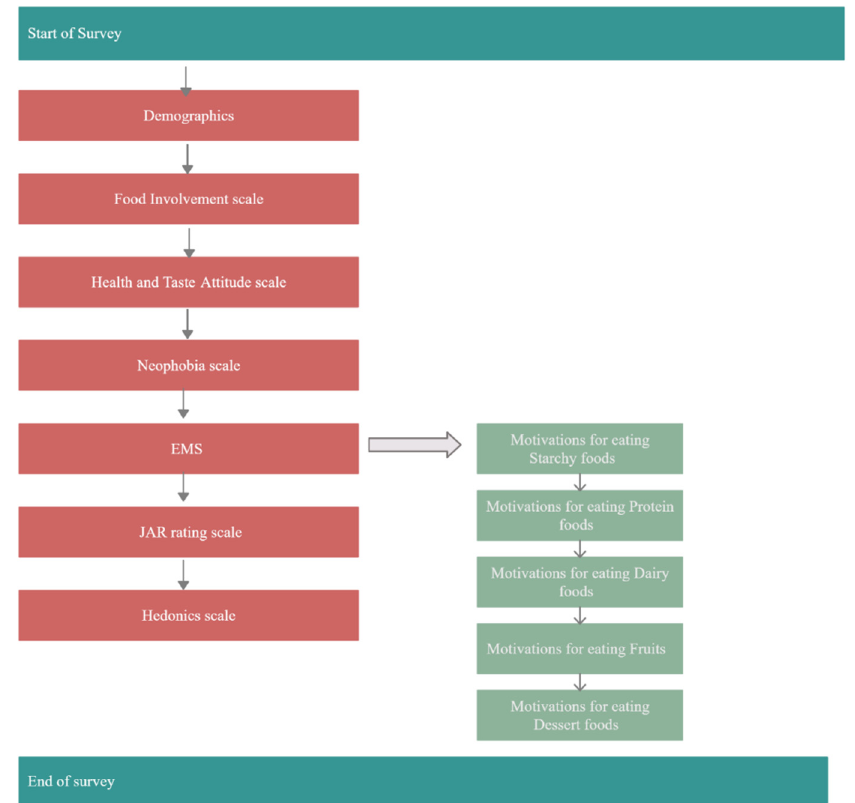
Figure 2. Flowchart showing the flow of questions of the entire survey questionnaire. EMS = Eating Motivation Survey; JAR = Just-About-Right